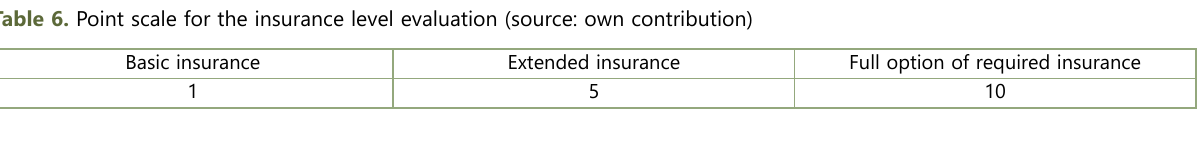
Table 7. Point scale for the number of carrier’s certificate evaluation (source: own contribution) Lack of certificates